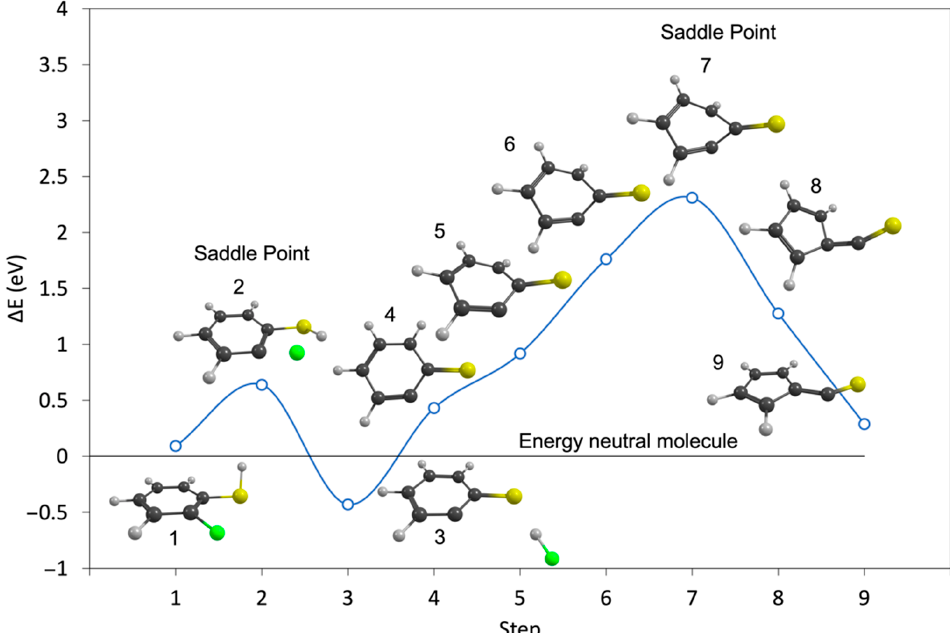
Figure 4. Minimum energy path for the direct HF loss (steps 1–4) and the formation of the 5-membered ring C 5 F 4 –CS − (steps 4–9) from the anionic ground state of 2-FTP (step 1), calculated using the NEB-TS method at the B3LYP D3BJ/aug-cc-pVTZ level of theory. Step 4 corresponds to the direct HF loss, i.e., without the rearrangement of the ring. The single point energies (open circles) along the reaction paths are relative to the energy of the neutral parent molecule, which is set to 0 eV (horizontal black line). ZPVEs and thermal energy correction for the neutral molecule were taken into account.